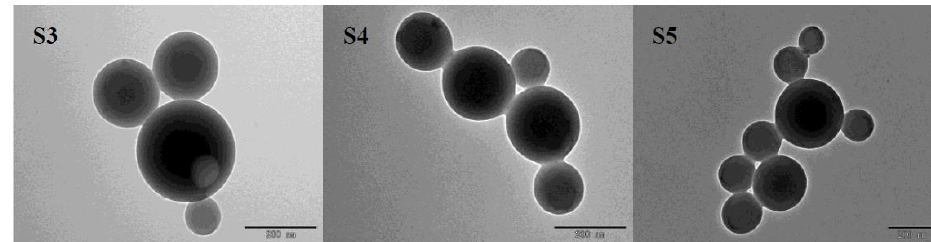
Figure 6. TEM images of polymeric micelles S3, S4 and S5 (scale bar: 200 nm, 0.02 gL − 1 ).